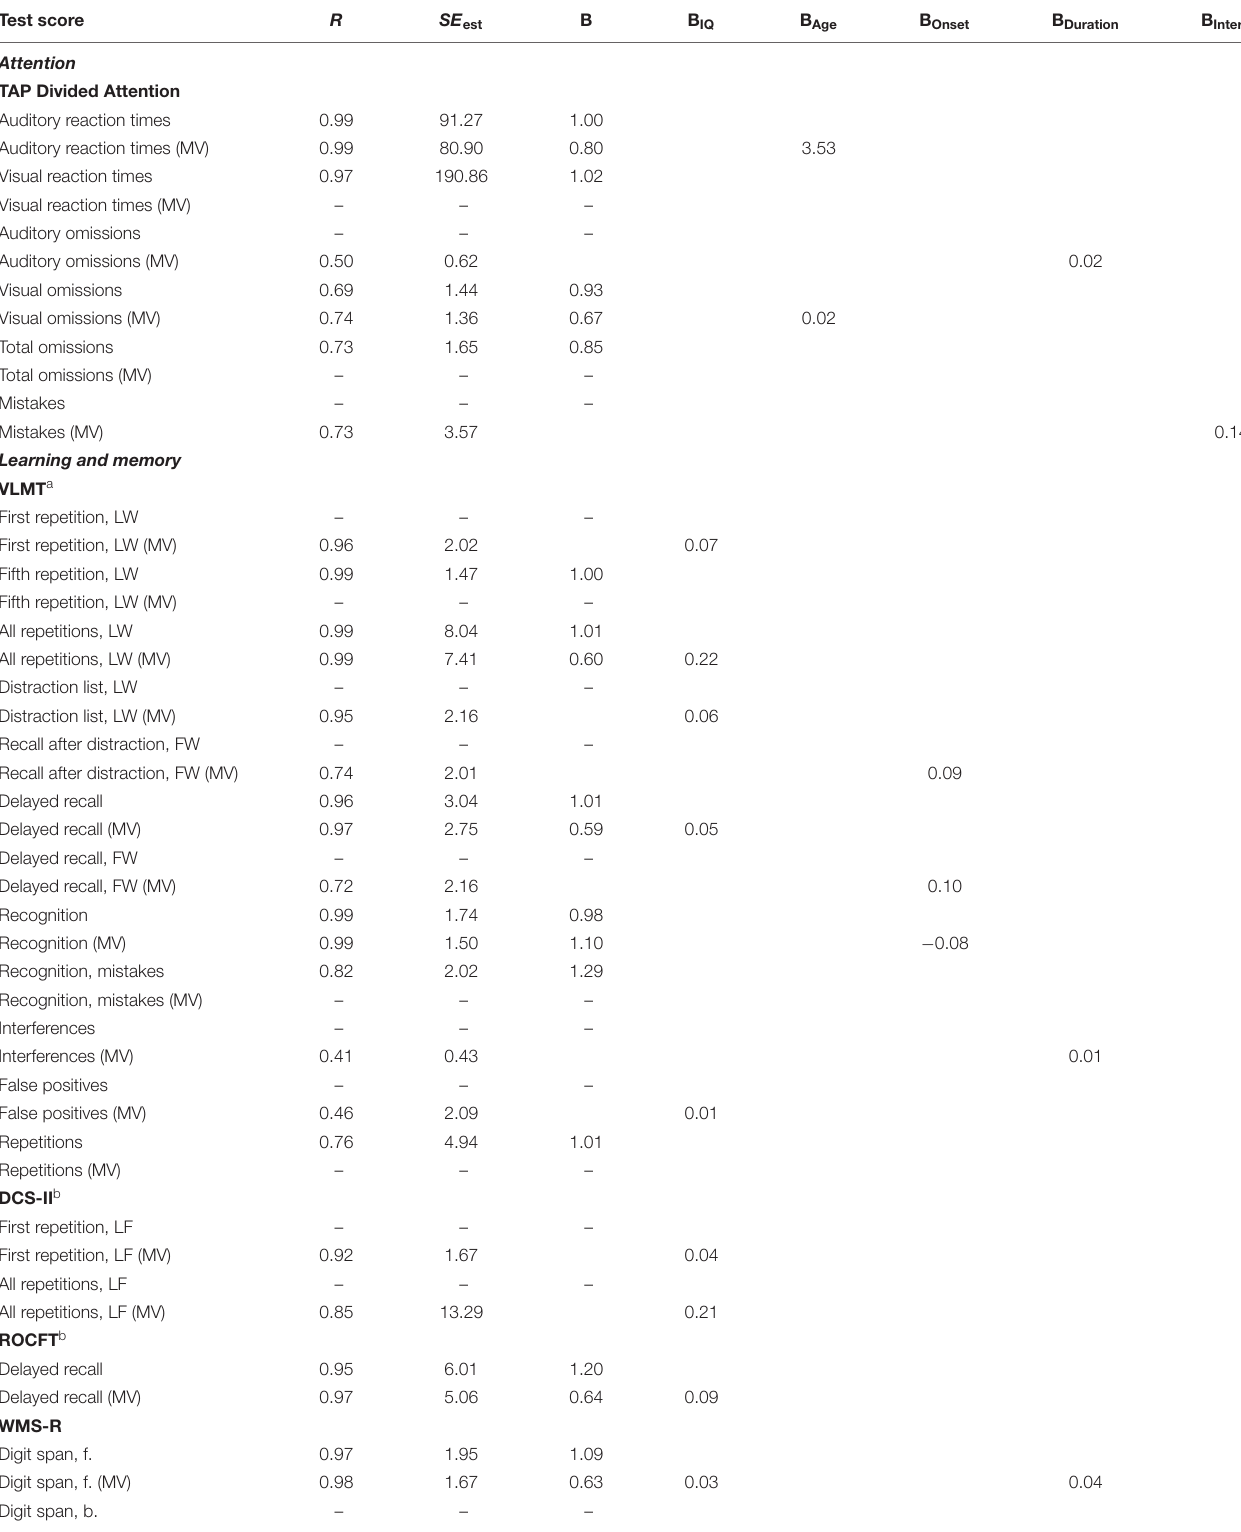
TABLE 4 | SRB equations for each neuropsychological test score, with and without moderating demographic and clinical variables (MV) where applicable. Test